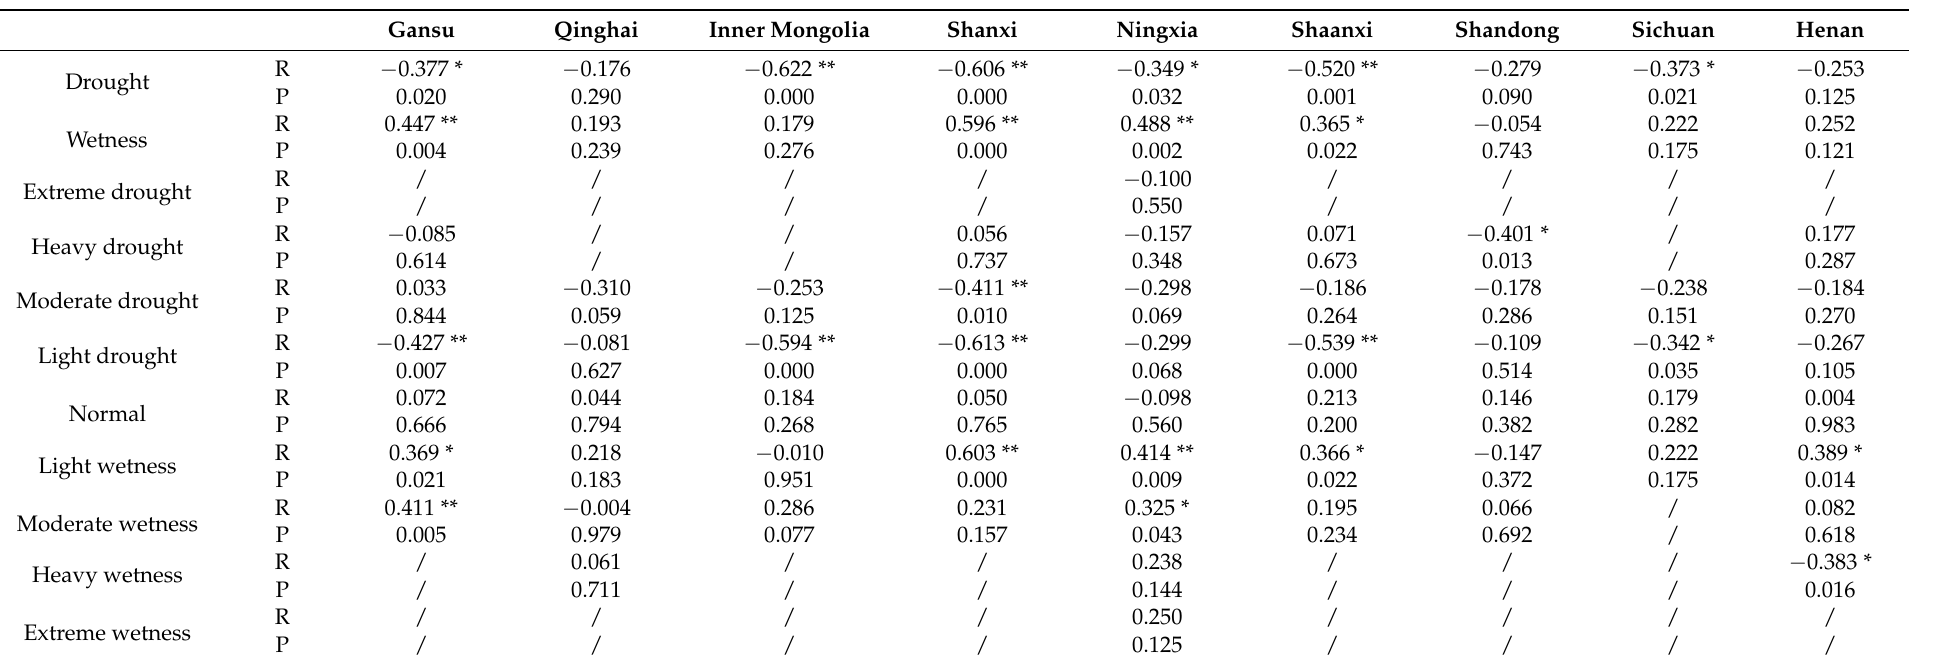
Table 3. Partial correlation coefficient between drought and wetness frequency and grain yield per unit area in the Yellow River basin from 1979 to